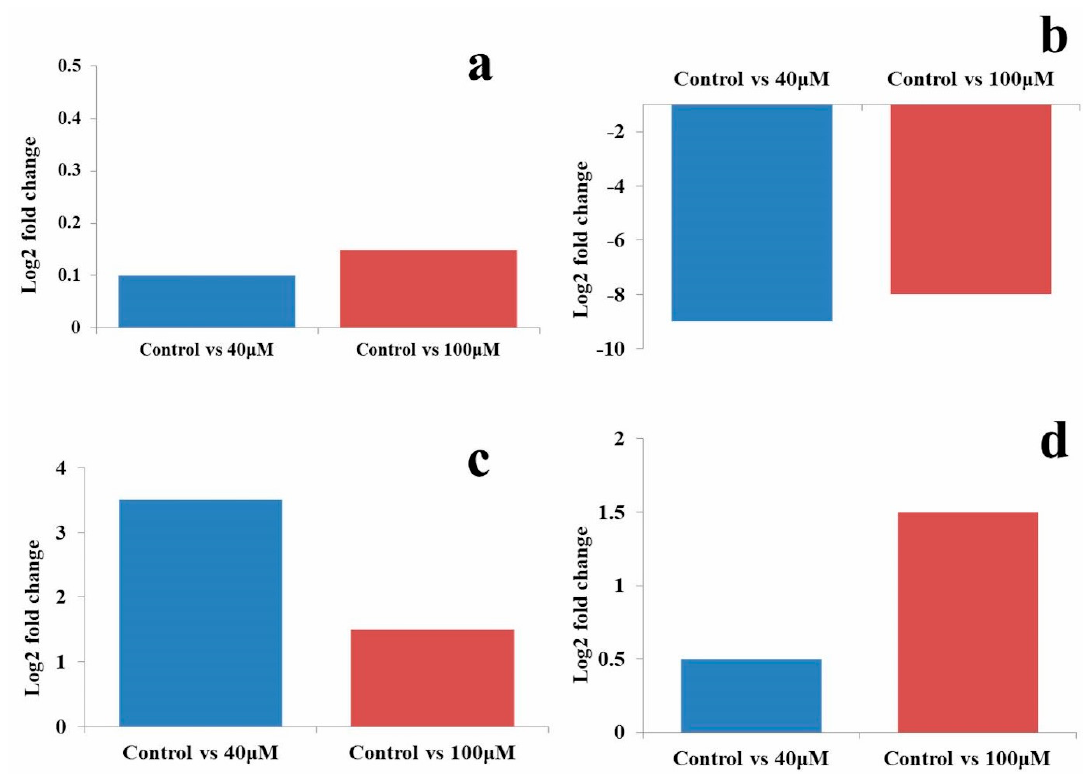
Figure 11. Log2 fold change obtained by NGS dataset in the untreated control vs. 40 and the untreated control vs. 100 µ M EGCG treatments. ( a ) miR-21-5p; ( b ) hsa-miR-548o-5p; ( c ) hsa-miR-181c; ( d ) hsa-miR-212-5p microRNAs.